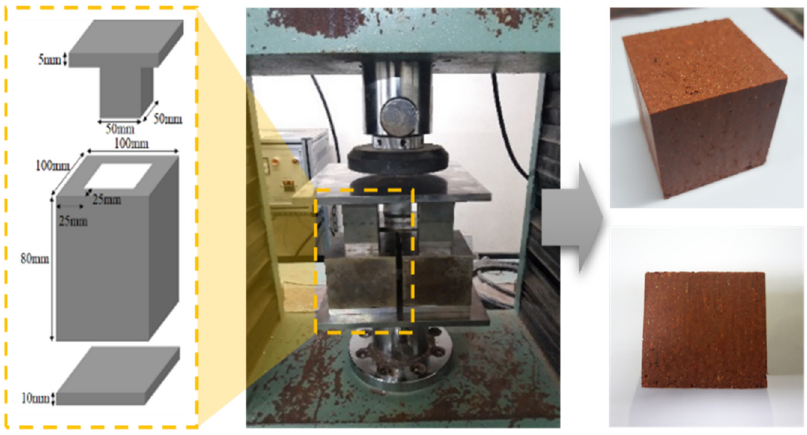
Figure 6. Mold, manufacturing apparatus, and specimen.